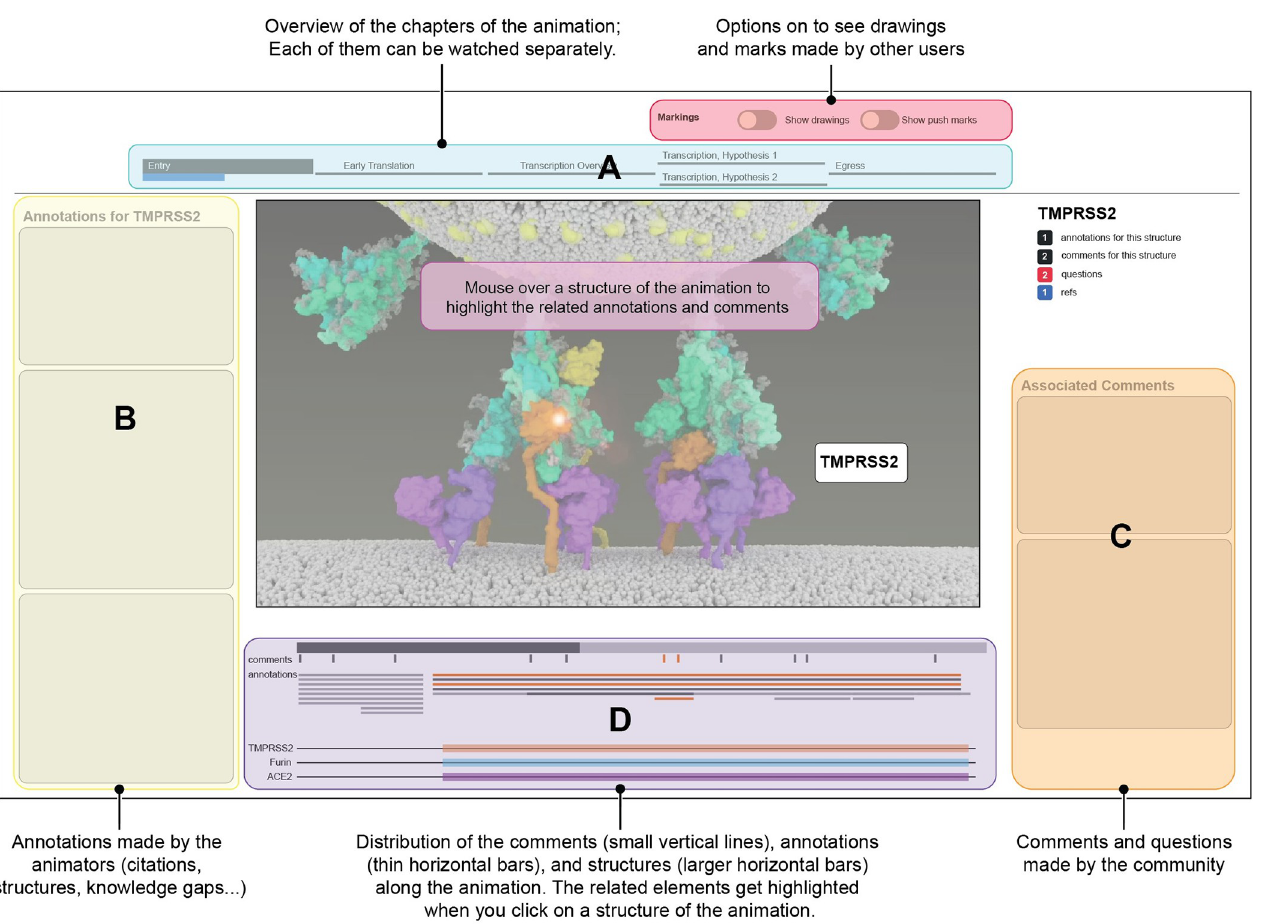
Fig 2. Key capabilities and features of the web-based annotation and commenting tool. These include in particular a time outline with branched chapters representing alternative hypotheses that can be viewed independently (A); annotations provided by animators (B); comments and questions the community (C); both annotations and comments are also highlighted in a clear overview (D). Visit https://coronavirus-annotation-3.sci.utah.edu/ to try it